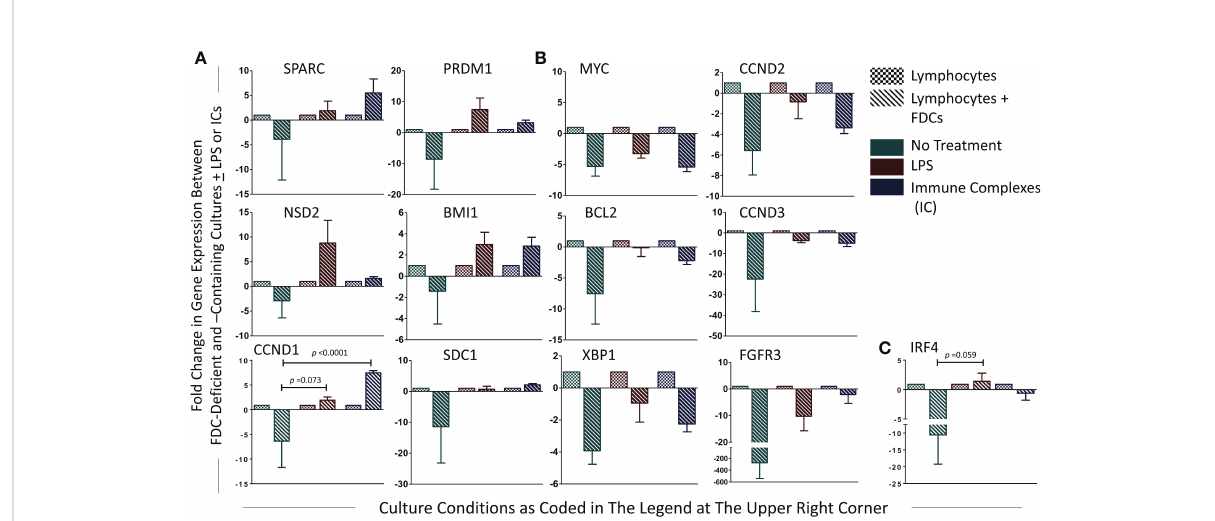
FIGURE 8 Fold change in PC-associated genes ’ expression in lymphocytes + FDCs vs. lymphocytes. For each gene, fold change in the relative expression due to addition of FDCs to the lymphocytes was calculated using the equation (2 - DD CT ), and the results were presented. Unpaired T-test was used to compare results in control (lymphocytes) with coculture groups (lymphocytes + FDCs) [whether untreated or treated with LPS or ICs], and signi fi cant p values were presented. Data represent mean ± SEM of three independent experiments. SPARC, NSD2, CCND1, PRDM1, BMI1, and SDC1 showed upregulated expression with LPS and IC treatment (A) , whereas MYC, BCL2, XBP1, CCND2, CCND3, and FGRF3 expressions were reduced (B) . IRF4 displayed increased and decreased expression with LPS and ICs respectively (C) , p value in LPS-stimulated cultures of IRF4 and CCND1 was 0.059 and 0.073,